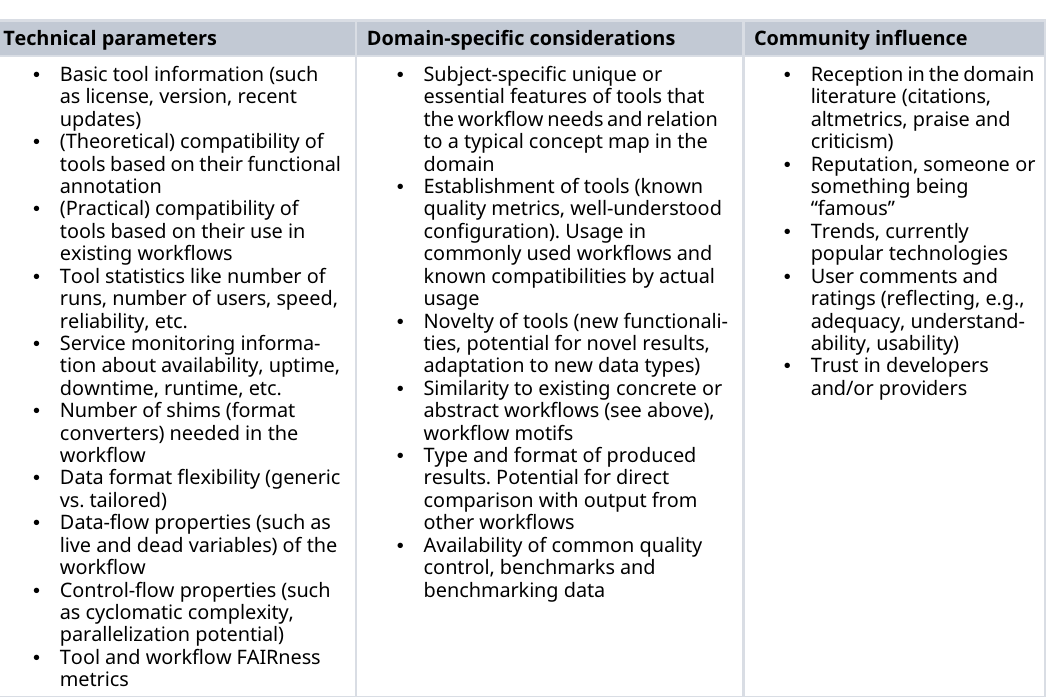
Table 1. Relevant information for static analysis of